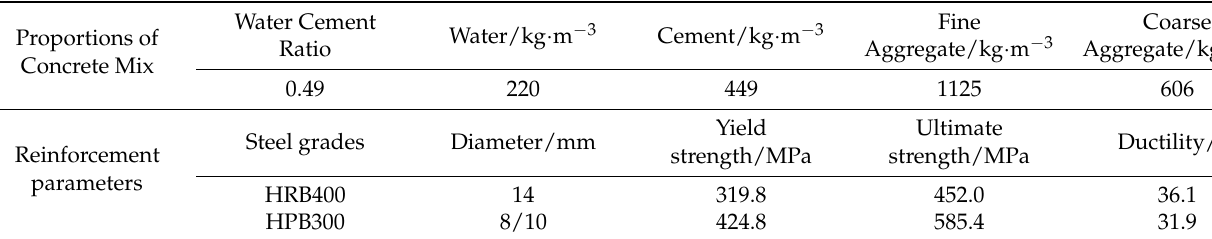
Table 1. Concrete and reinforcing steel information.